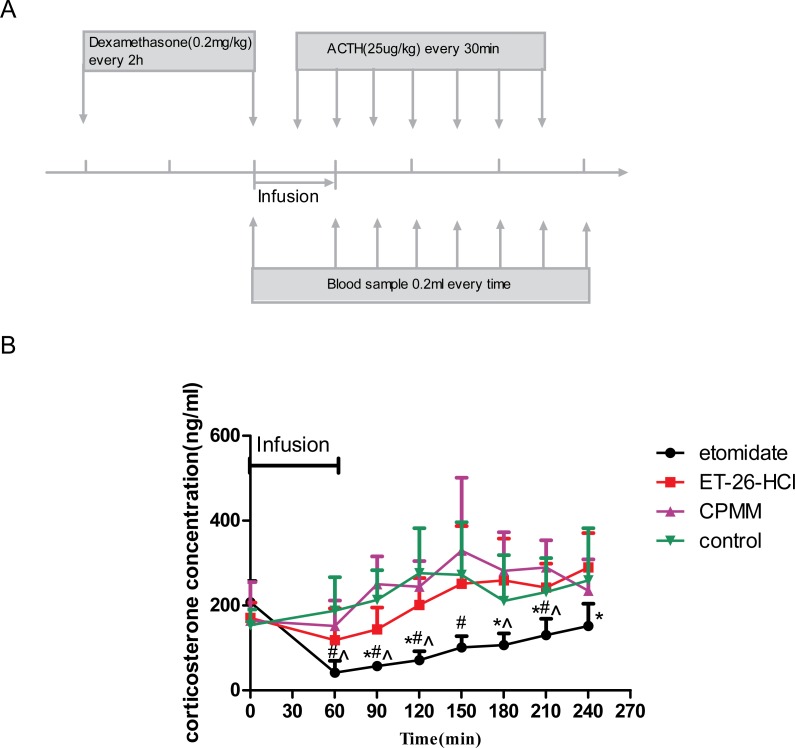
Determination of serum corticosterone concentrations.(A) Schematic depicting the experimental protocol. Before the hypnotic drug infusion, the first blood sample was drawn as the baseline. Adrenocorticotropic hormone (ACTH) was injected intravenously after 30 min of drug infusion and then once every 30 min for the duration of the experiment. The second blood sample was collected at the end of the drug infusion, and then blood samples were drawn every 30 min for 3.5 h. (B) Adrenocortical function as determined by serum corticosterone concentrations after hypnotic drug infusion. ∗P < 0.05, for etomidate versus ET-26-HCl; #P < 0.05 for etomidate versus control; \documentclass[12pt]{minimal}
\usepackage{amsmath}
\usepackage{wasysym} 
\usepackage{amsfonts} 
\usepackage{amssymb} 
\usepackage{amsbsy}
\usepackage{upgreek}
\usepackage{mathrsfs}
\setlength{\oddsidemargin}{-69pt}
\begin{document}
}{}$\hat {P}\lt 0.05$\end{document}P ˆ<0.05 for etomidate versus CPMM. Eight rats were used in each group.